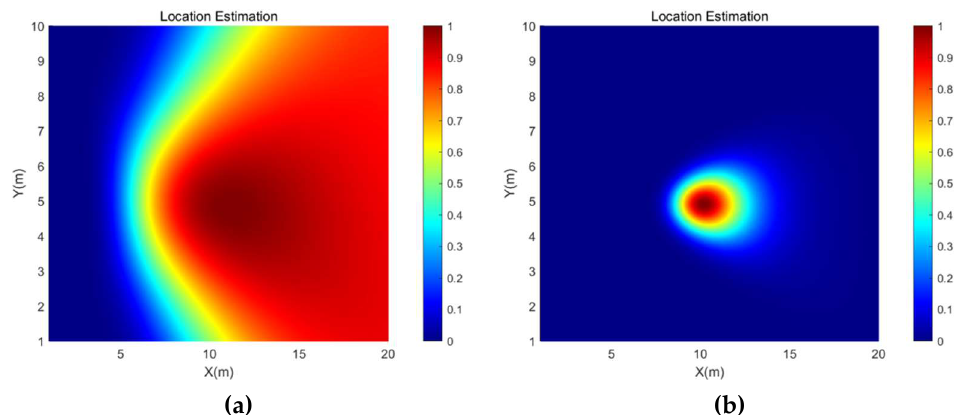
Figure 8. The direction estimation experimental results of (a) SRP-PHAT and (b) SRP-MCCC when the sound source coordinate is (10, 5).